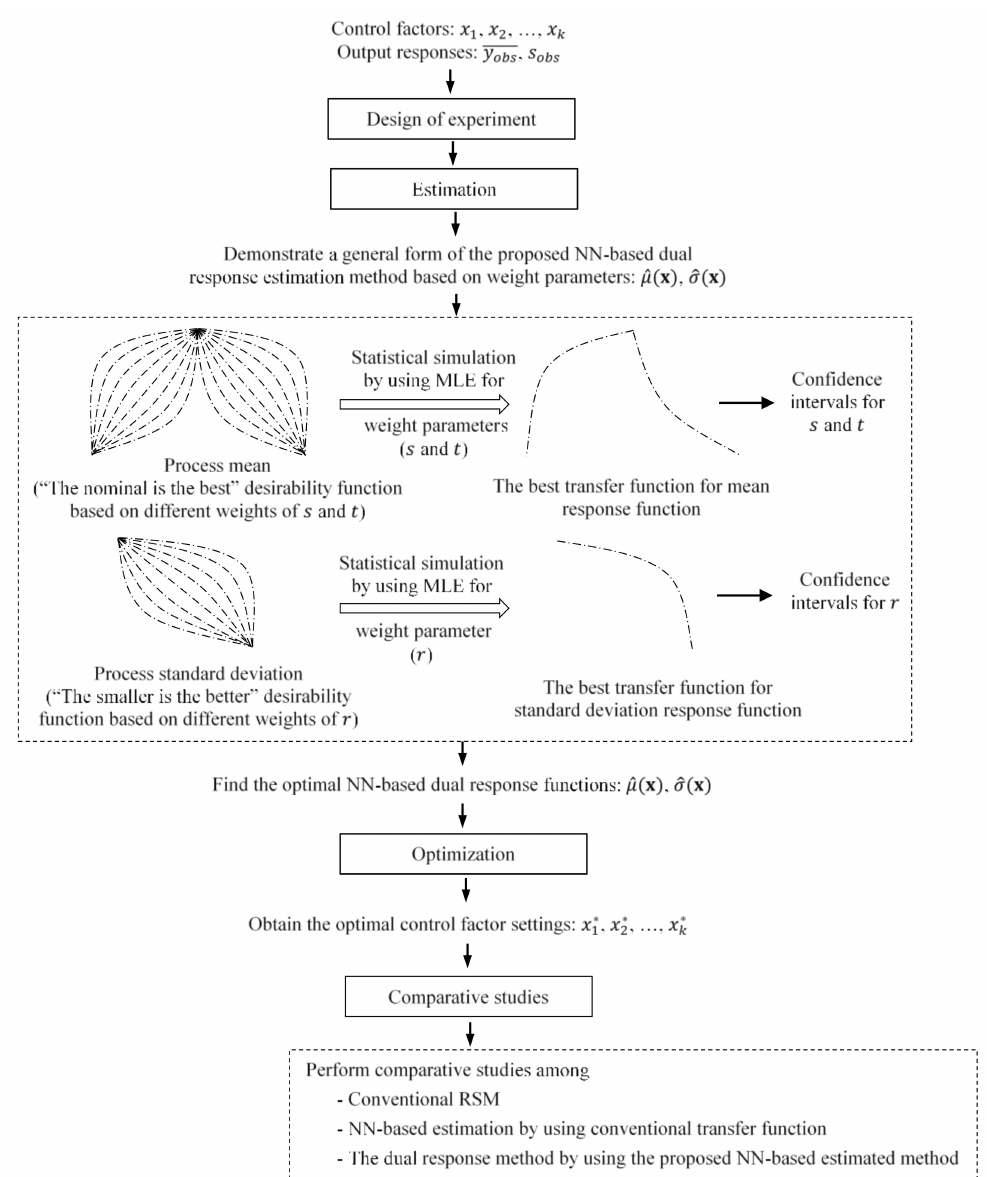
Figure 1. Overview of the proposed NN-based DR function estimation